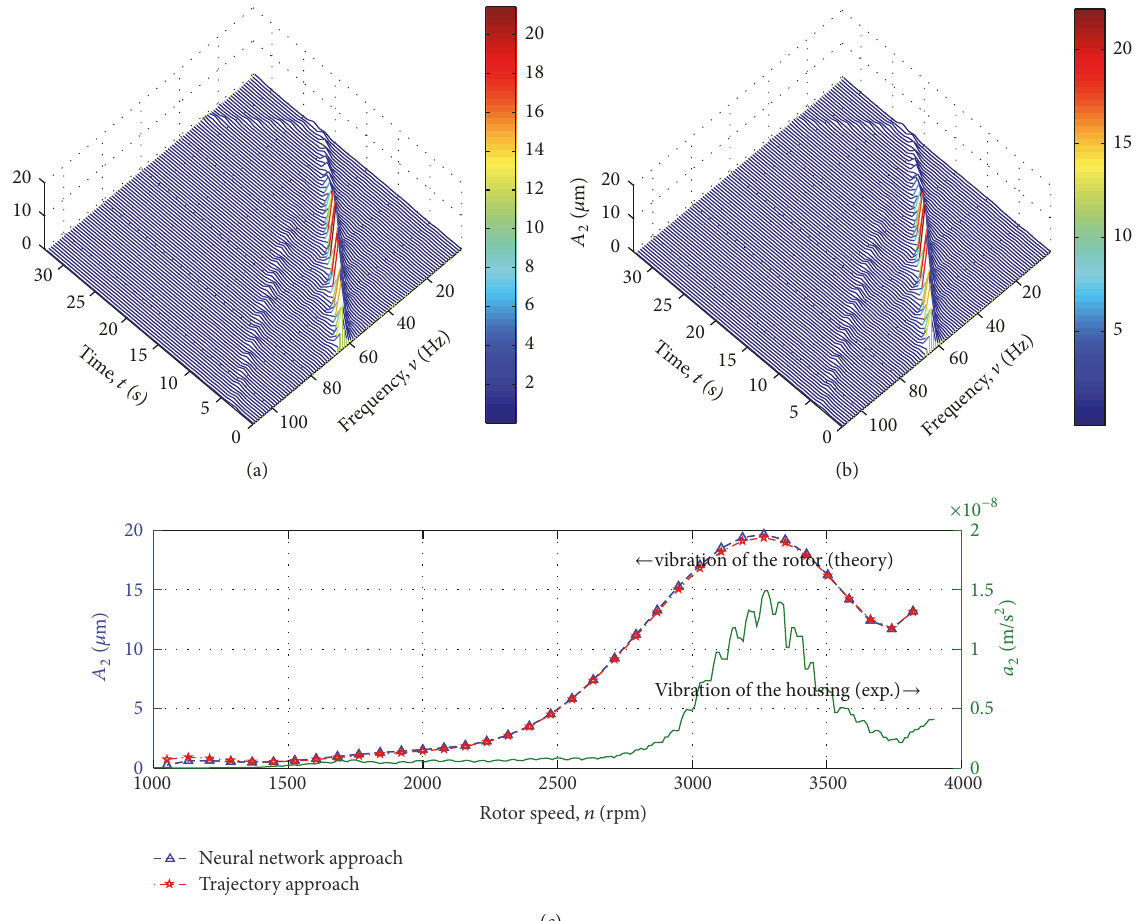
Figure 8: Cascade frequency response during deceleration of the rotor from 3900 rpm down to 1000rpm during 32 sec., calculated using the trajectory approach (a), neural network approach (b), and comparative results of the housing’s vibration measurement and the rotor’s vibration calculation